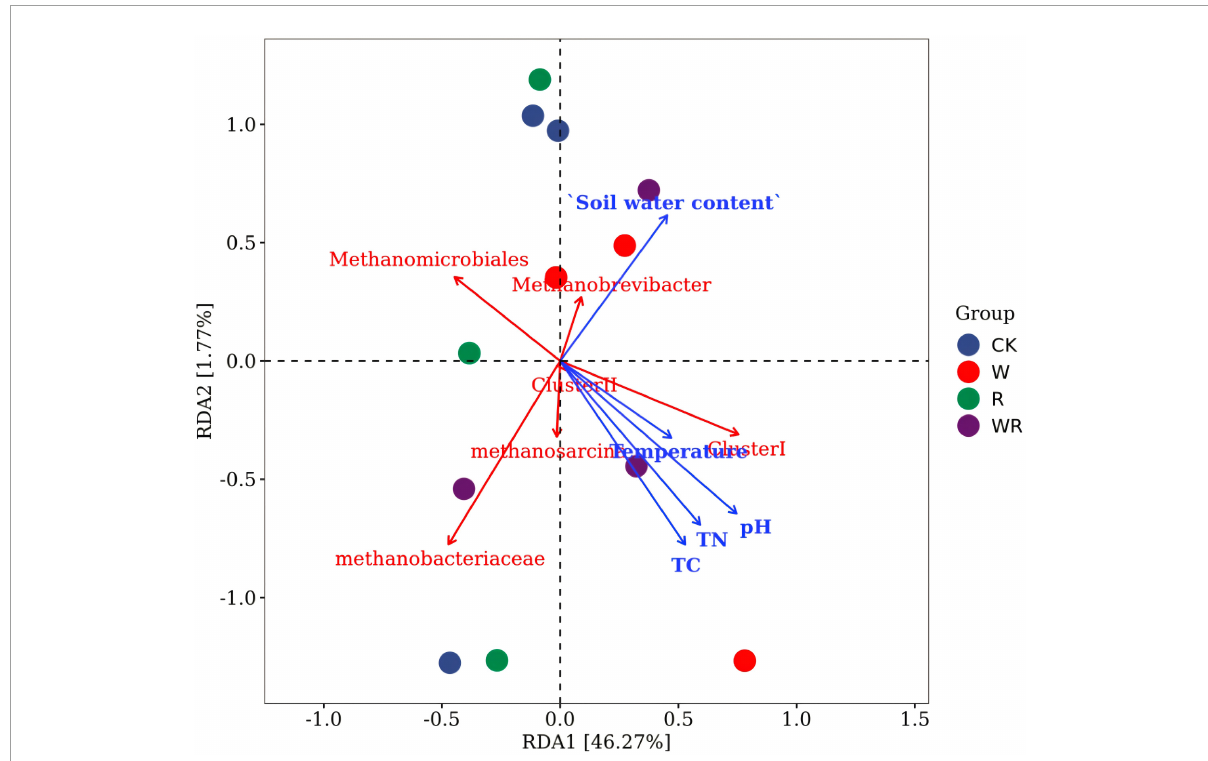
FIGURE4 RDA plot of methanogenic communities in relation to environmental factors. CK, Control (no warming or drought); W, warming; R, 20% drought; WR, warming + 20% drought.